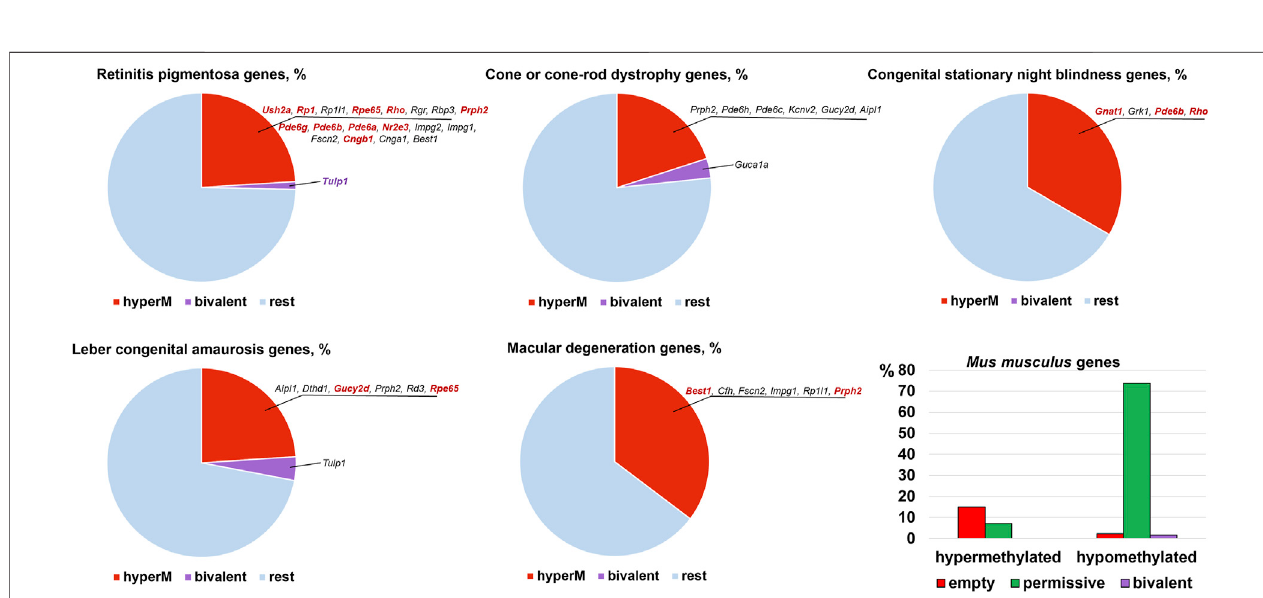
FIGURE3| The many mouse homologs ofhumangenes whosemutationslead toRP, CCRD, CSNB, LCA, and MD havethe same hypermethylated promoters in embryonic retinas/RPCs as human genes, while genes with bivalent promoters were different. Many promoters in an “ empty ” chromatin state were hypermethylated. Mutations in the genes colored bright red account for the majority of cases of the respective diseases.